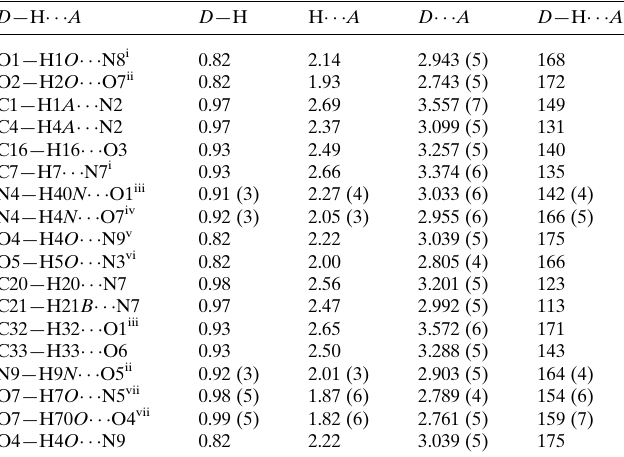
Table 1 Hydrogen-bond geometry (A˚ , (cid:4) ). D —H (cid:2)(cid:2)(cid:2)